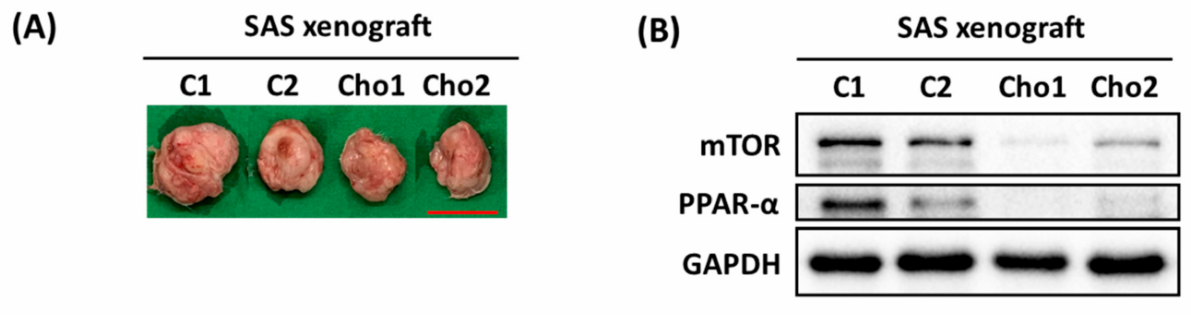
Figure 4. Effect of chrysophanol on SAS-xenograft mouse model. ( A ) Photos show tumors excised af- ter sacrifice on day 30. ( B ) Changes in mTOR and PPAR- α expression in tumors from BALB/cAnN.Cg- Foxn1nu/CrlNarl mice from two groups: control (saline) and chrysophanol 1.67 mg/kg 3 times per week for 4 weeks. C1 and C2 indicate independent mice injected with 5 × 10 6 cells without chrysophanol treatment ( n = 2). Cho1 and Cho2 indicate independent mice injected with 5 × 10 6 cells with 1.67 mg/kg chrysophanol treatment ( n = 2). Scale bar = 2.5